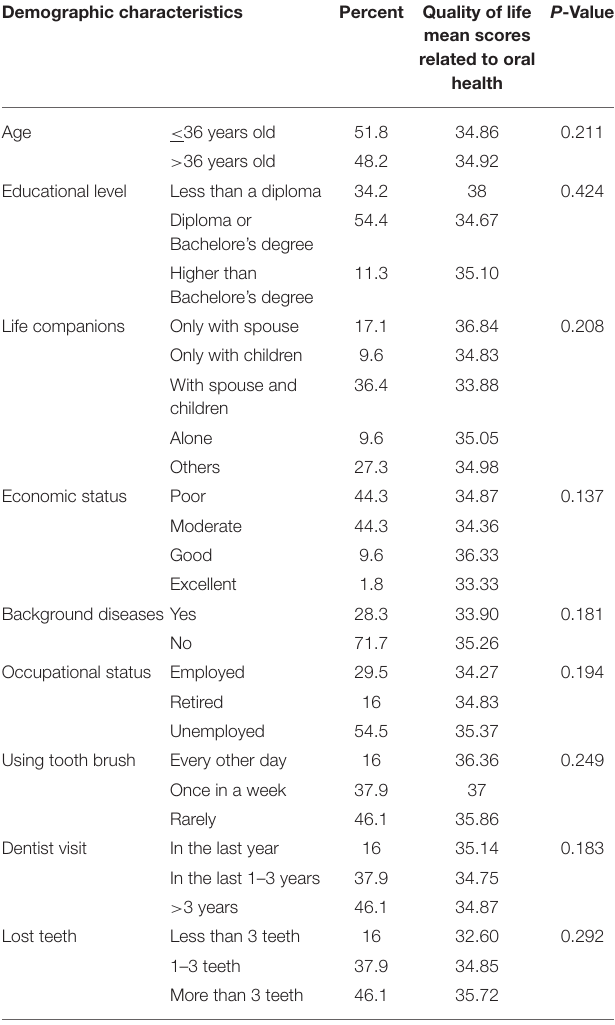
TABLE 1 | Relationship between quality of life related to oral health and variables of study. Demographic